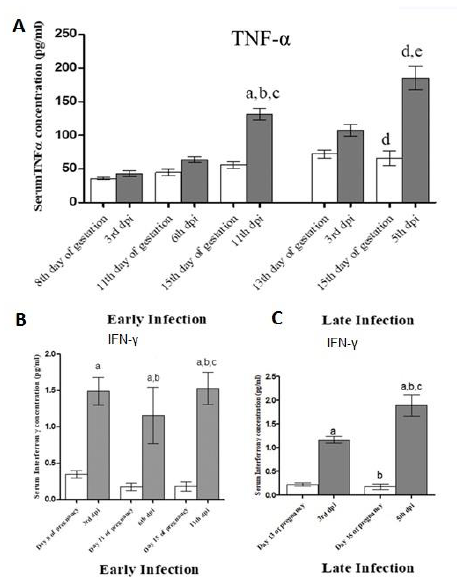
Figure 11. ( A ) Serum concentrations of TNF- α in hamsters inoculated with EHV-9 (1 × 10 4 pfu) in early and late trimesters in comparison with the control group. ( B ) and ( C ) Serum concentrations of IFN- γ in hamsters inoculated with EHV-9 (1 × 10 4 pfu) in early (a) and late (b) trimesters in comparison with the control group. Data are represented as mean ± SE. Statistical analysis performed by one-way analysis of variance followed by the Tukey Cramer test for multiple comparisons ( p < 0.05). The letters (a–e) superscripted the columns are referred to the significance between groups represented in the